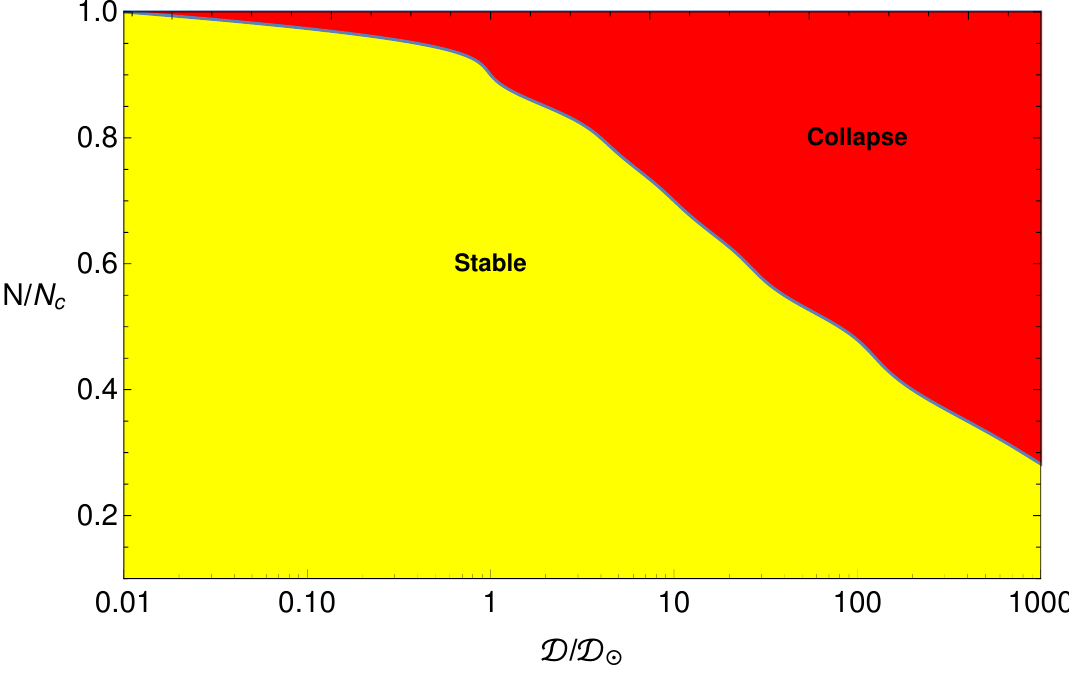
Figure 5 . The parameter space for ASt collapses induced by collisions with ordinary stars. We identify two regions parameterized by the ratio of particle number to critical ( N=N c ), and density compared to stellar density ( D = D (cid:12) ): a stable region with bound, dilute energy minima (yellow), and a collapse region with no dilute minimum